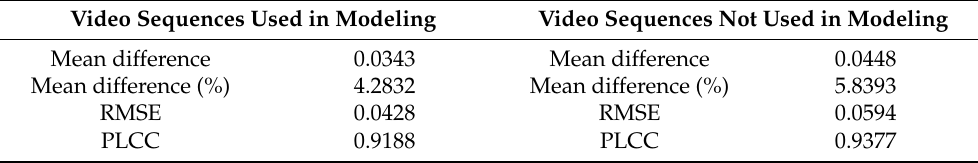
Table 5. Comparison between the measured SSIM and SSIMenv values for video sequences used in modeling (C53, MC, C47, S2, PA, SK, GTA, TSR, EM SO and BS) as well as for video sequences not used in the modeling process (BBB, ED and TR).